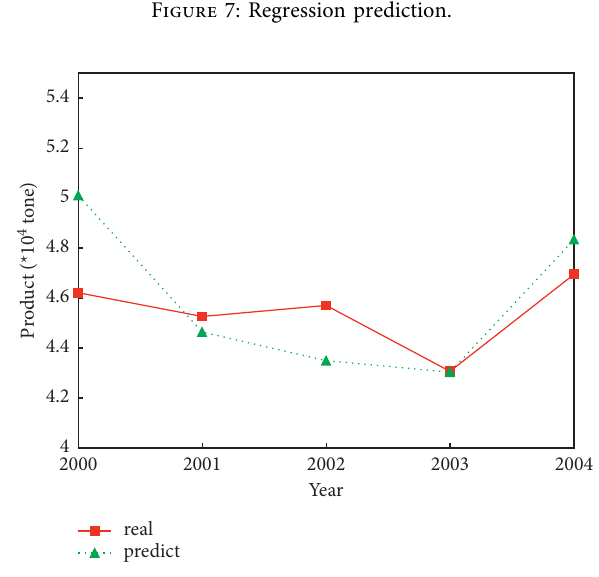
Figure 8: GM (1, N ) prediction.